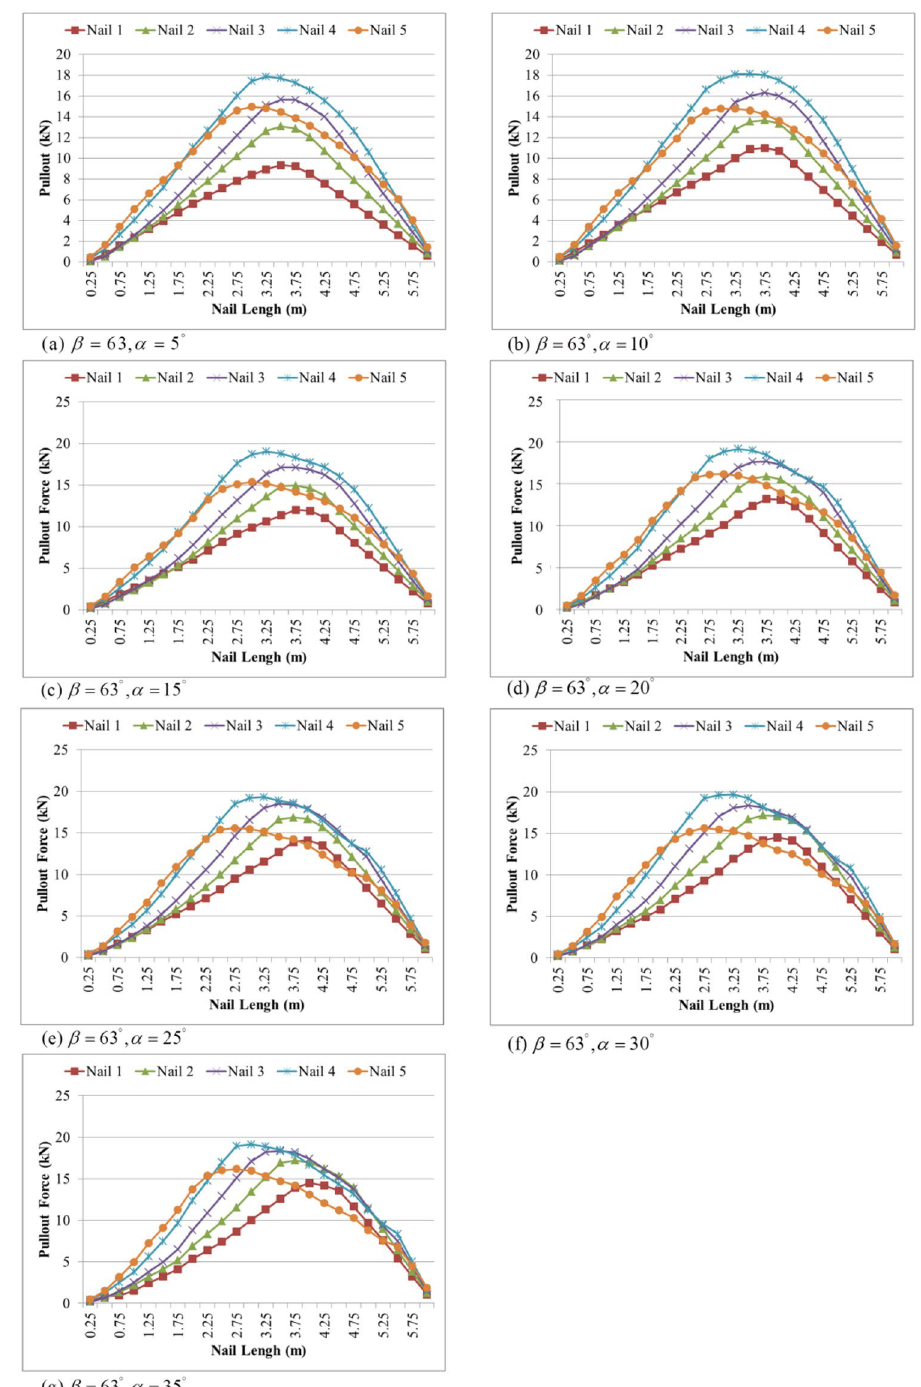
Fig. 8 Plots of the maximum pull-out force of nails in terms of the nail length with nails installed in the slope which has an angle of β = 63°, and at dif- ferent angles ( α = 5° to α =